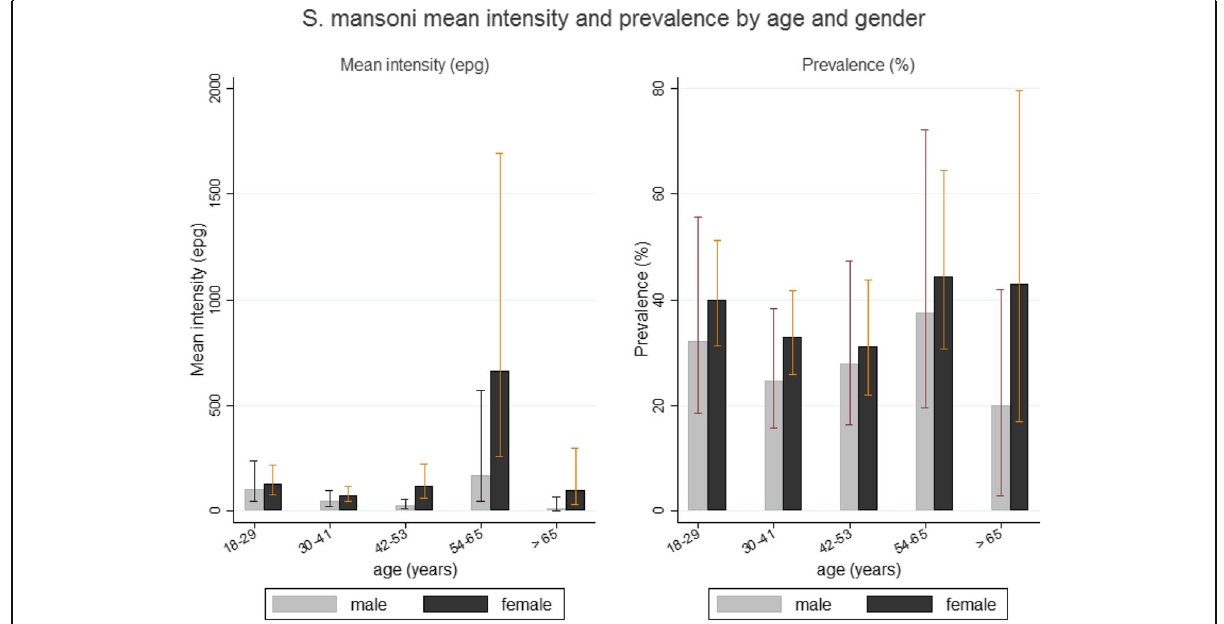
Fig. 1 S. mansoni mean intensity and prevalence by age and